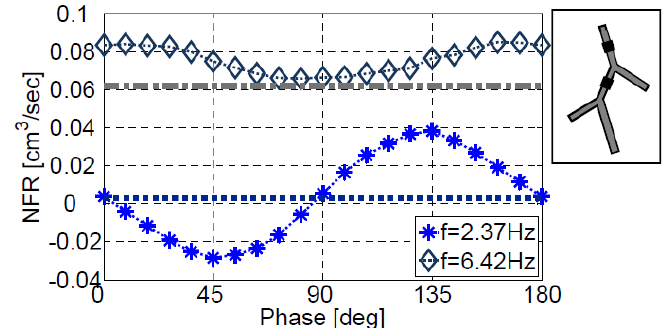
Figure 13. The effect on the NFR of the phase between two actuators positioned on the first and the second vessels of configuration V. The first actuator is located at X C / L 1 = 0.4 of the first vessel and the second actuator is positioned at X C / L 2 = 0.8 of the second vessel. The dotted and the dash-dotted lines show the NFR for a single actuator positioned at X C / L = 0.4 of the first